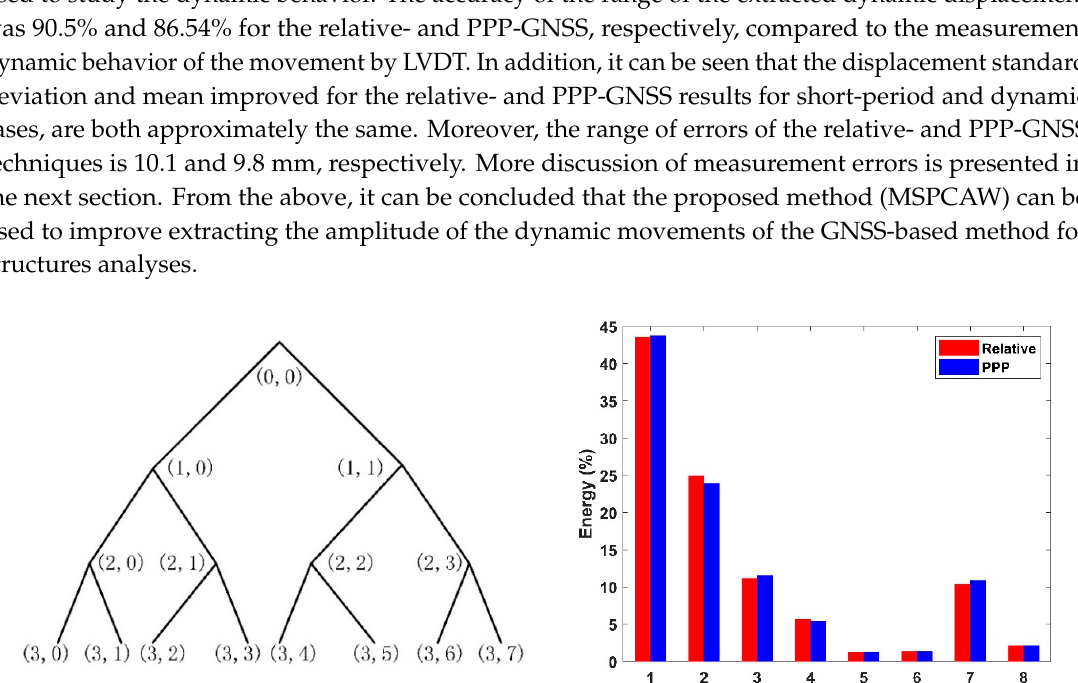
Figure 8. MSPCAW evaluation in amplitude, ( a ) apparent displacement, ( b ) relative measurement filter, ( c ) short-period component, and ( d ) dynamic component.